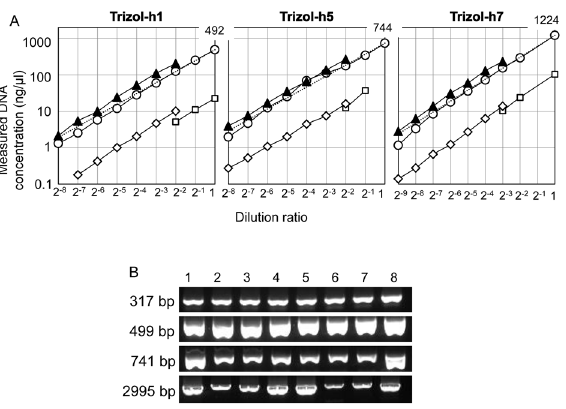
Fig 5. Quantification and qualification of Trizol-DNA. (A) Trizol-DNA was serially diluted with distilled water, and the concentration of each diluent was measured by NanoDrop (circles), BR-Qubit (squares), HS-Qubit (diamonds) and qPCR (triangles). The broken line indicates the expected NanoDrop value. The concentration (ng/ μ l) of each original DNA solution, as measured by NanoDrop, is shown at the top right: dilution ratio = 1. The detection limits of each measurement are described in Fig 1. (B) Various lengths of the target sequence were amplified from Trizol-DNAs, and the amplified products were electrophoresed on an agarose gel. Lane 1, Frozen-H1; lane 2, Trizol-h1; lane 3, Trizol-h2; lane 4, Trizol-h3; lane 5, Trizol-h4; lane 6, Trizol-h5; lane 7, Trizol-h6; and lane 8, Trizol-h7.